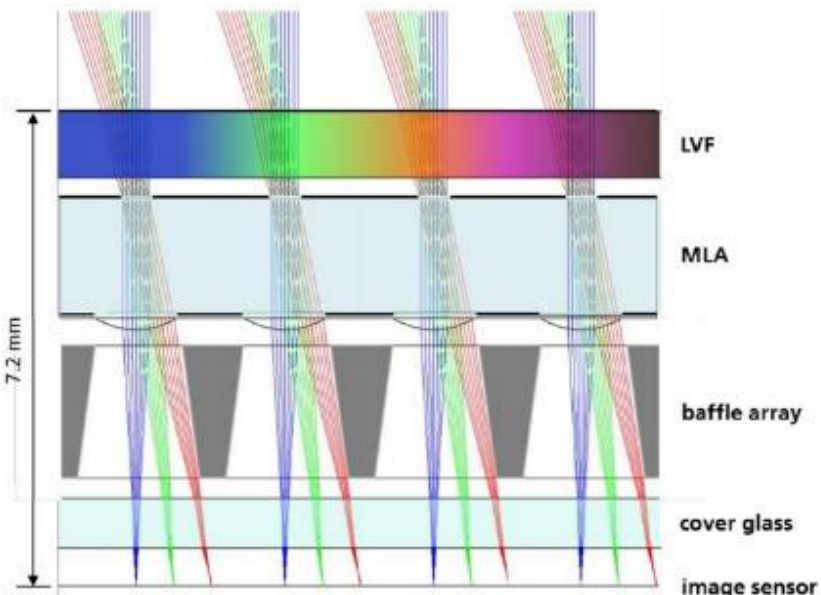
Figure 31. Schematic optical design of the ultra-compact micro-optical system for MSI with a linear variable filter (LVF), microlens array (MLA), and customized baffle array.